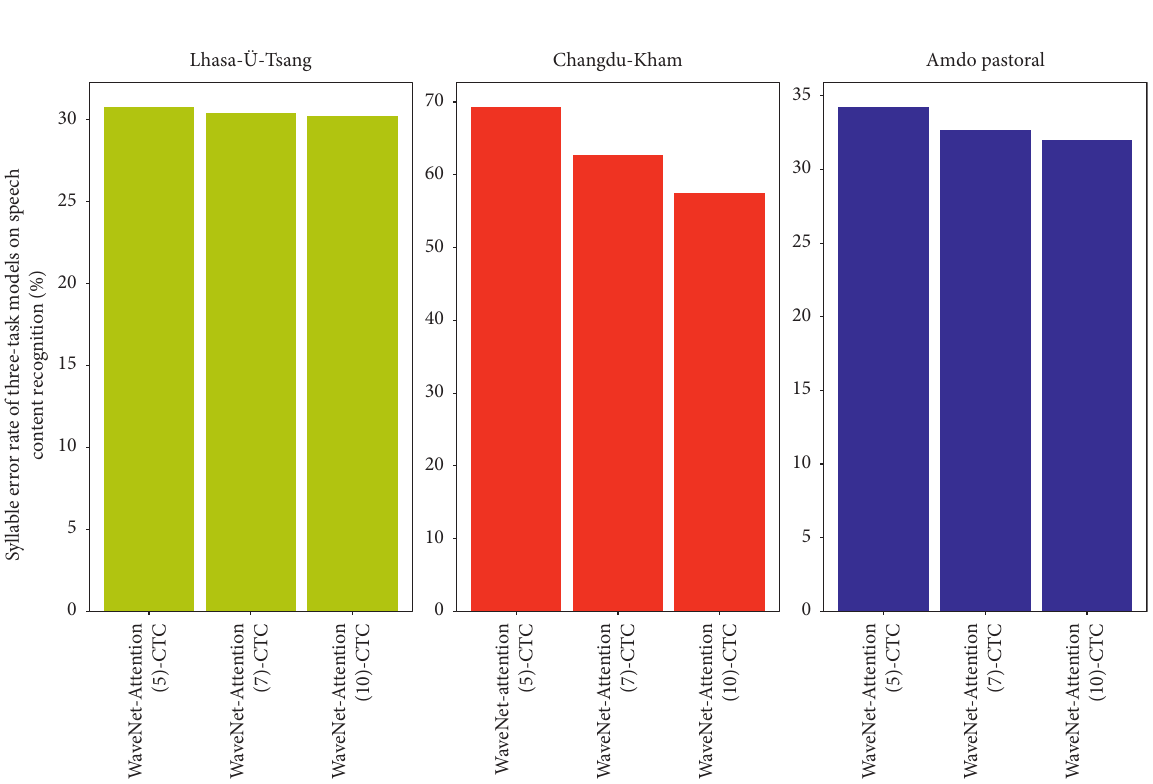
Figure 7: Syllable error rate of WaveNet-Attention-CTC for different lengths of the attention